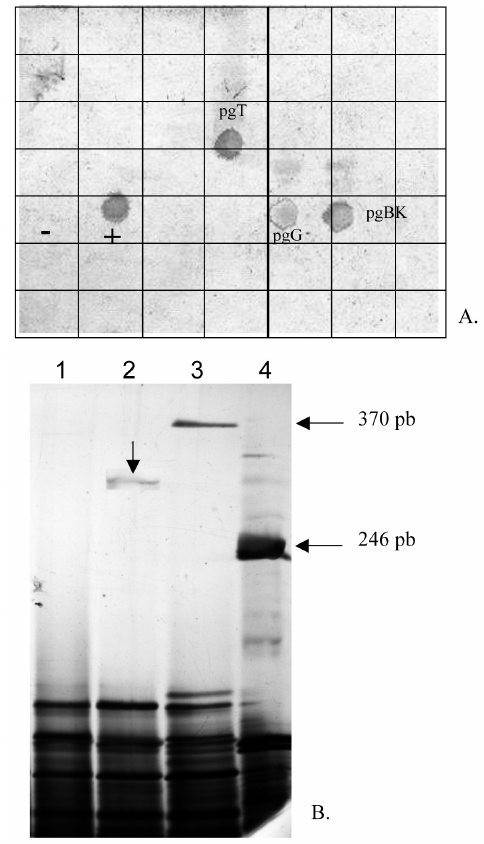
Figure 1. A. Nitrocellulose membrane showing dot-blot hybridization of citrus Hop stunt viroid (HSVd) DIG- labeled cDNA probe to total RNA of pgT, pgG and pgBK samples naturally infected with HSVd. The healthy control (-) and the pGEM-T-HSVd cDNA control (+) are also shown. B. HSVd from total RNA of infected pomegranate sample detected by S-PAGE and silver staining. Lane 1, healthy control; lane 2, HSVd-infected sample (indicated by an arrow); lane 3, CEVd (370 pb); lane 4, ASBVd (246